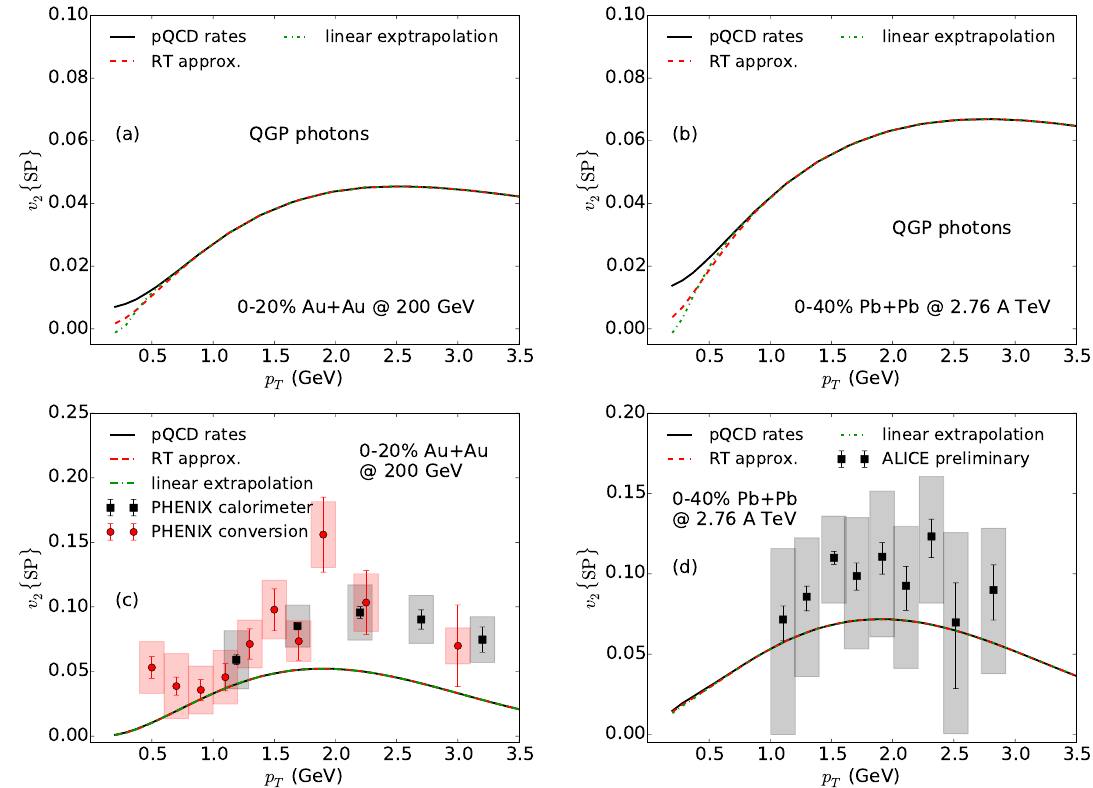
Figure 14 . QGP-photon (upper plots) and Direct-photon (lower plots) (cid:13)ow led by pQCD rates with di(cid:11)erent interpolations in low energy. Black curves here denote the original results without